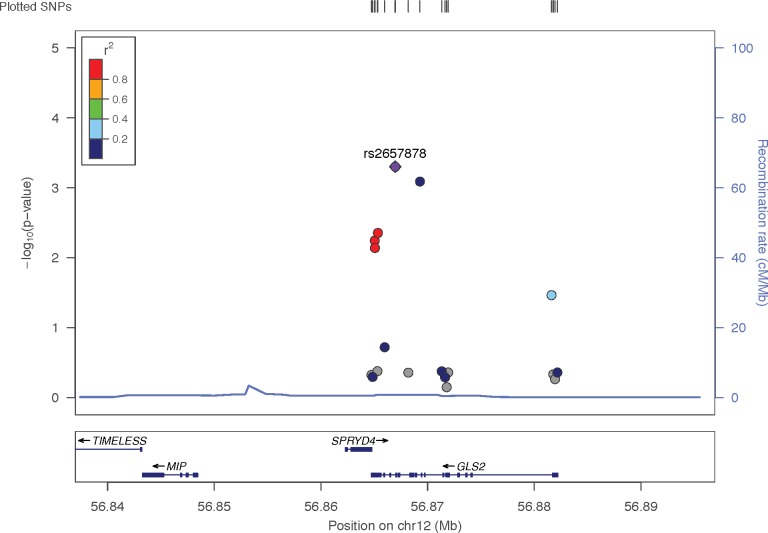
Regional association plot surrounding GLS2 in the overall replication sample.The–log10 p-values for individual SNV association tests are plotted against chromosomal position. The strongest association is at intronic variant rs2657878 (purple diamond). The next strongest result is at rs937115 (blue circle), an intronic variant in modest linkage disequilibrium (r2<0.2) with rs2657878 in the 1000 Genomes November 2014 European sample. Three additional variants (red circles), including missense variant rs2657879, are in strong linkage disequilibrium (r2>0.8) with rs2657878.